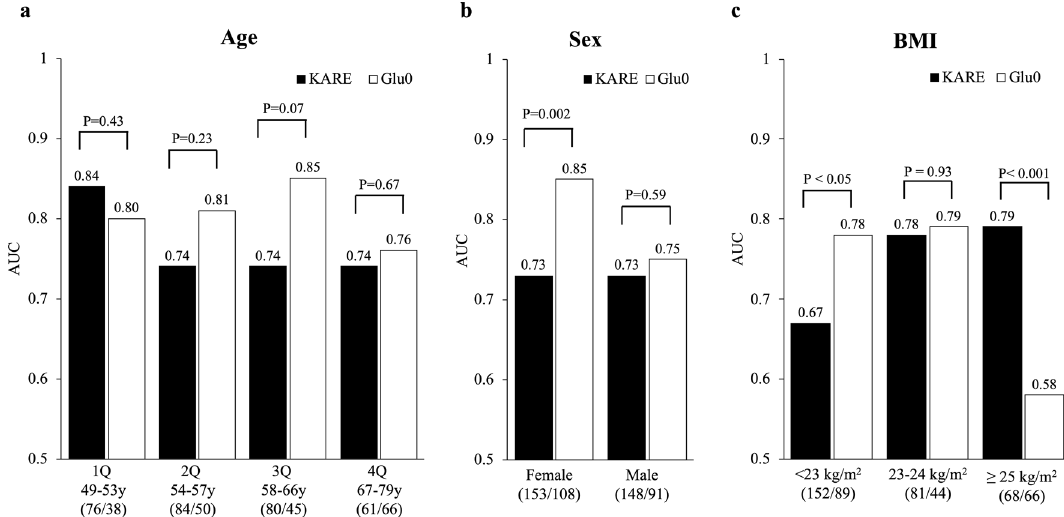
Figure 2. Comparisons of AUCs in the follow-up dataset according to age ( a ), sex ( b ), and BMI ( c ) groups. DeLong’s test was performed to compare AUCs between the KARE and fasting glucose (Glu0) prediction models. (/): number of controls and incident cases analyzed in the